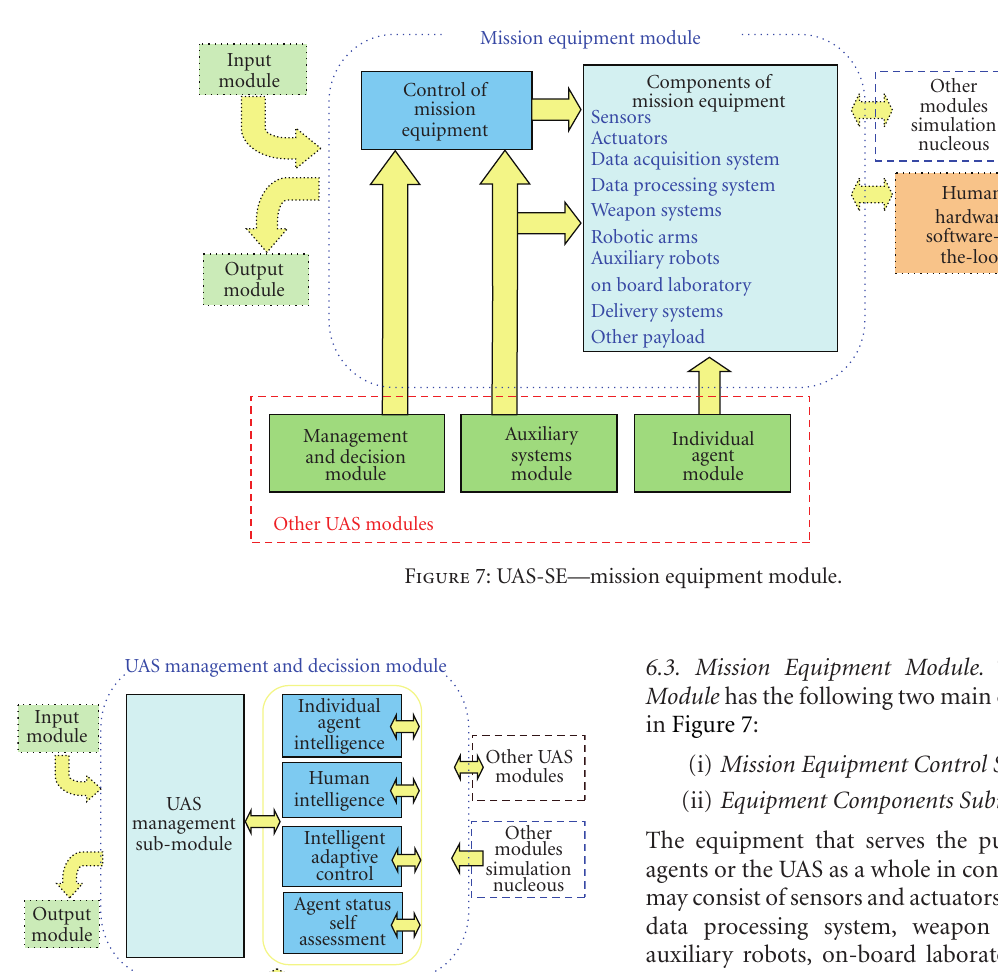
modeling the human personnel part of the UAS, possibly at a lower level of sophistication. This distinction is considered necessary to allow more detailed analysis of performance and component contributions to the complex